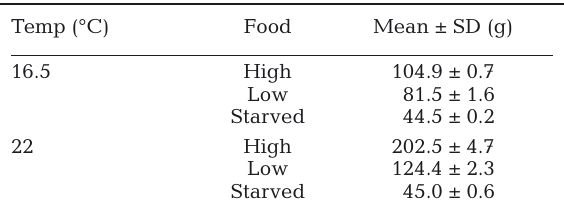
Table A1. Biomass of oysters in the tanks at the end of the acclimation period. Data are means ± SD (n = 3 tanks)